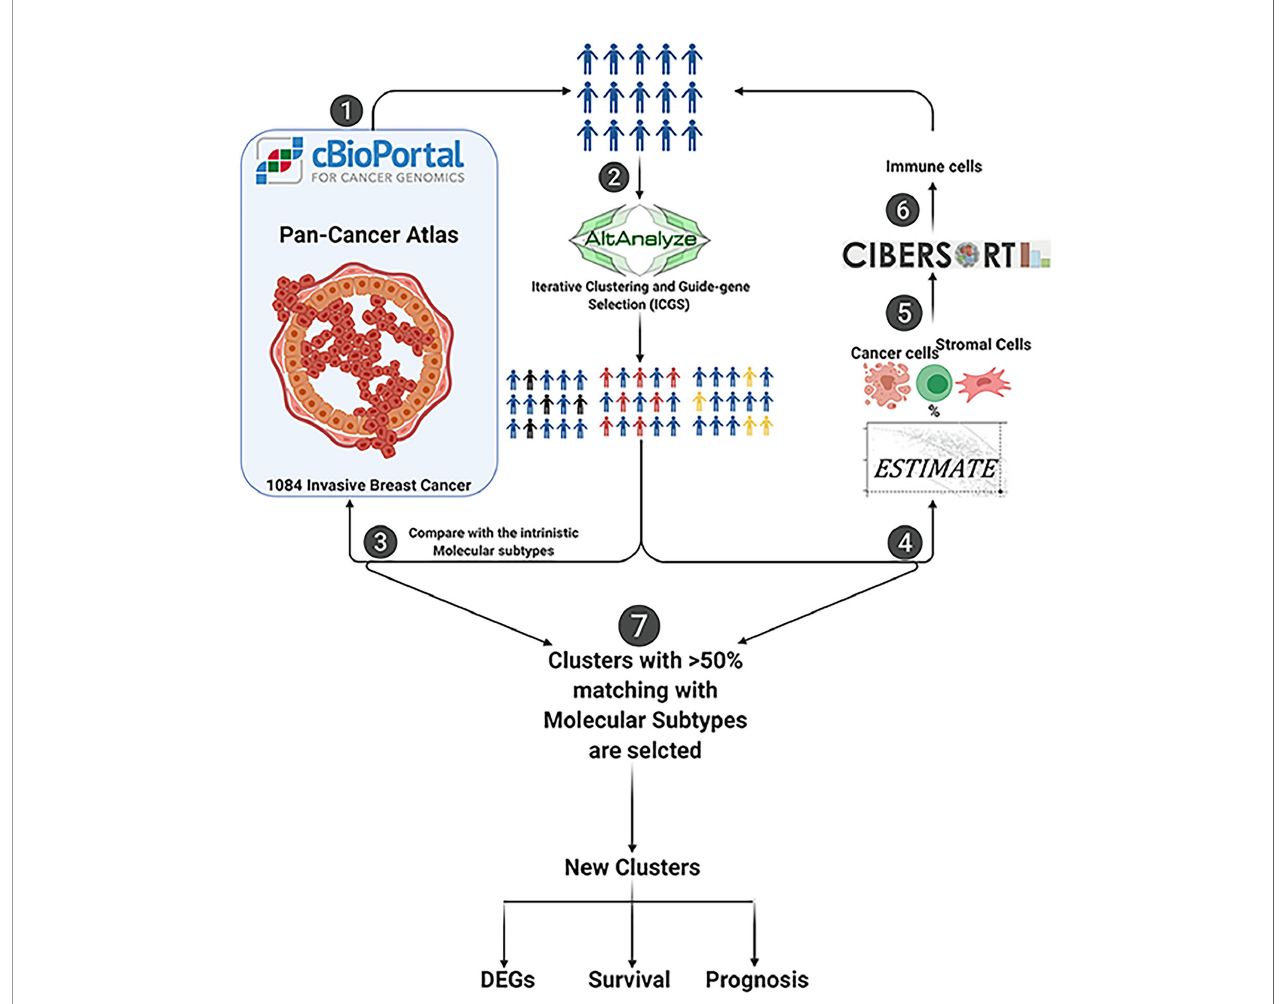
FIGURE 1 | Flow chart of the bioinformatics methodology